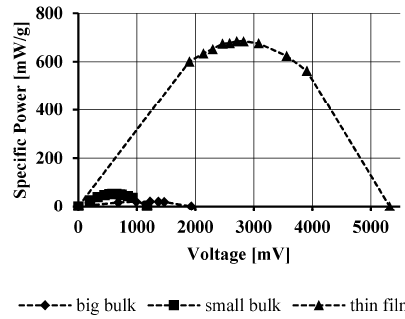
Figure 9. Specific power of three different TEGs at a temperature gradient of 50 K and a temperature level of 0 °C.